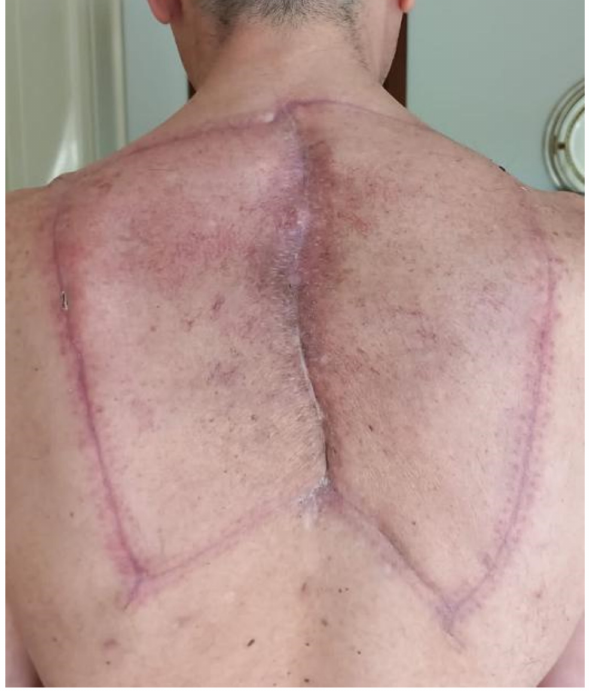
Figure 1. Follow‑up control of double keystone flap in wound dehiscence in irradiated skin. The defect on the midline is longitudinal and relatively small in width; it can be easily covered by two key stone